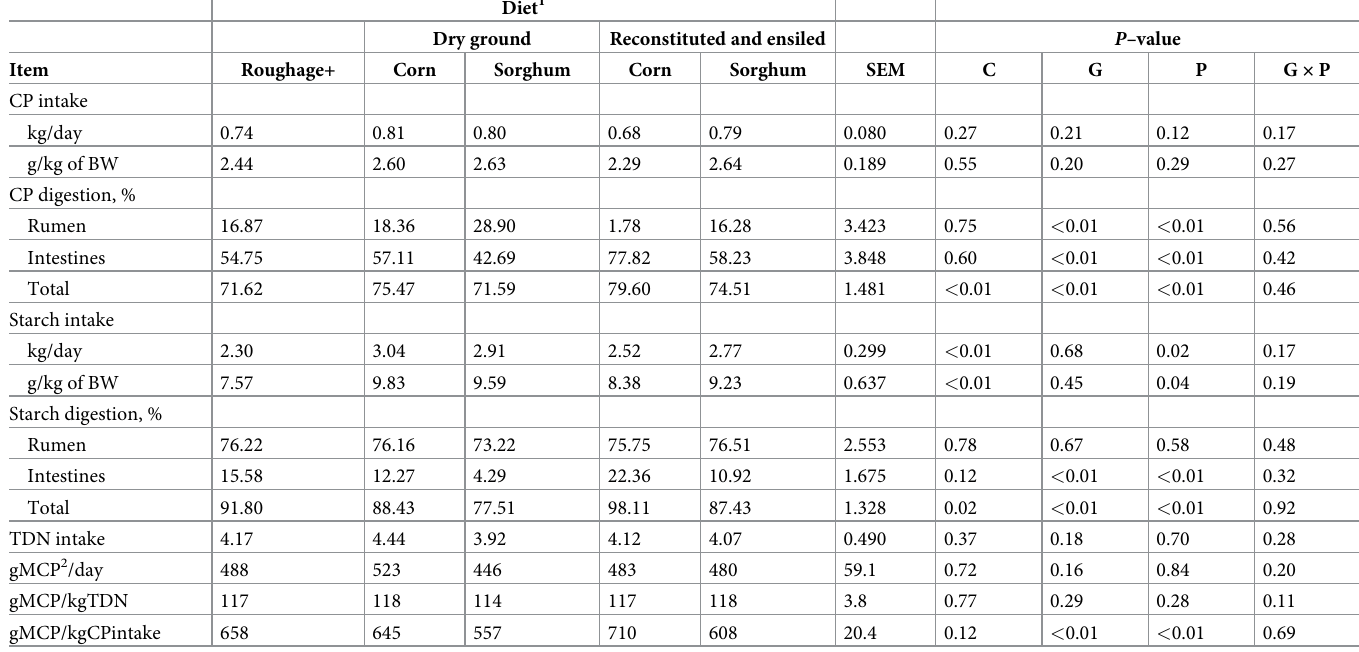
Table 3. Effect of contrate level, grain source and processing method on Crude Protein (CP) and starch intake and digestibility, Total Digestible Nutrient (TDN) intake and microbial efficiency of Nellore young bulls. Diet 1 Dry